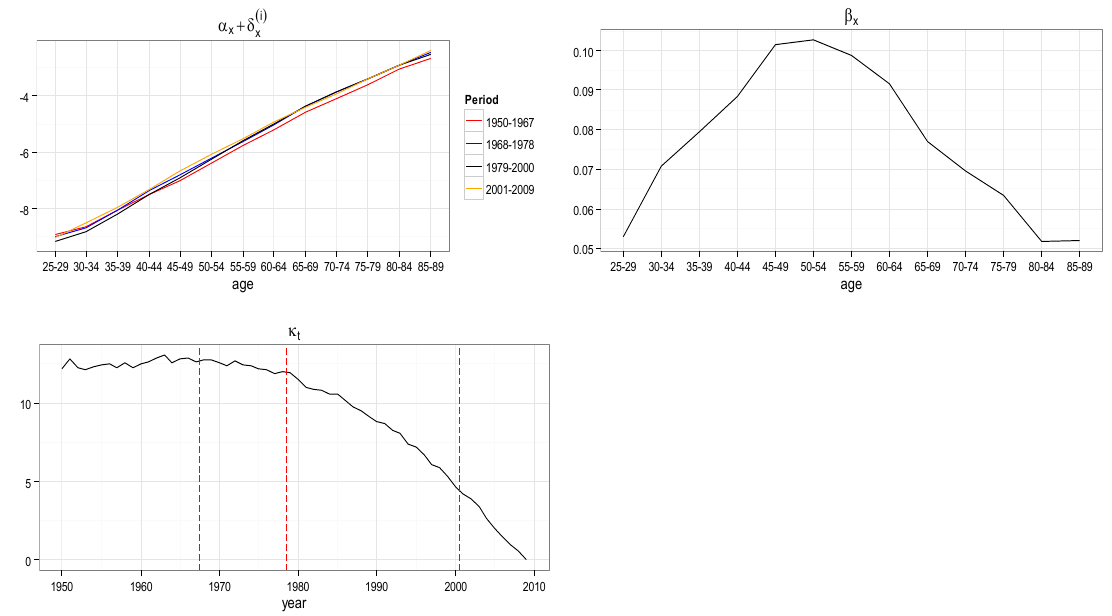
Figure 2. Model parameters, Cancer and Circulatory System Illness, UK Male population. On the axes of ordinates the parameter values.